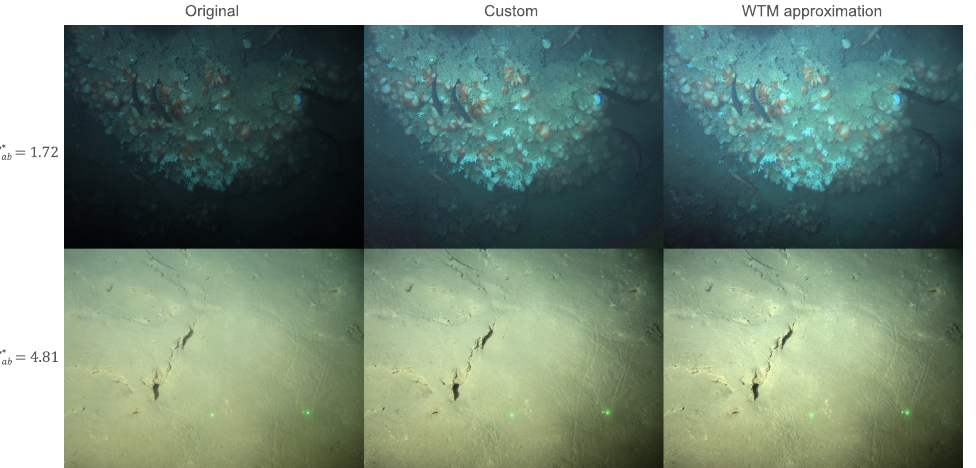
Figure 11. Example of WTM approximation of custom control-point adjustments. Colour difference between the custom and WTM image is summarised by mean ∆ E ∗